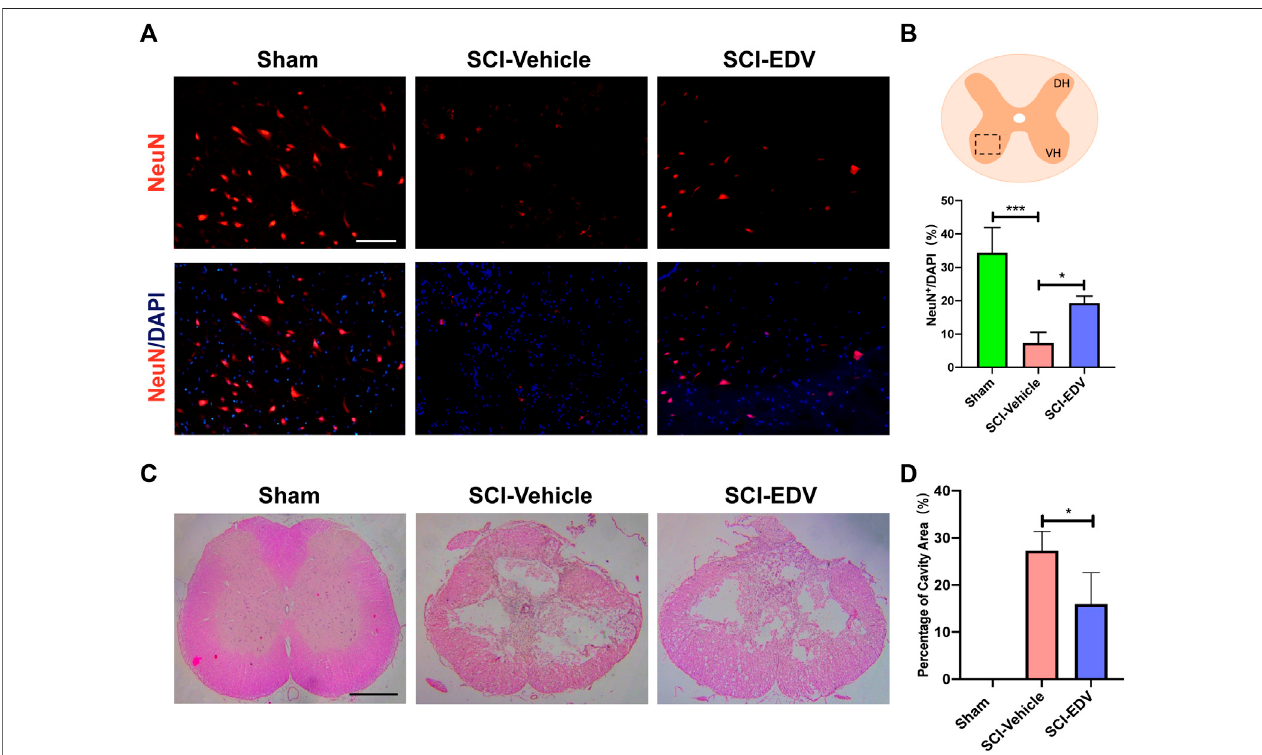
FIGURE 6 | Edaravone has a long-term effect on neuronal survival, reduced astrogliosis, and tissue sparing. (A) Representative images of immuno fl uorescence staining of NeuN in the injury epicenter of 8 weeks post SCI (B) Quanti fi cations of NeuN. (C) Representative images of H&E staining of spinal cord sections at 4 weeks post injury. (D) Quanti fi cation of cavity areas made by ImageJ. Data are expressed as mean ± standard deviation. Statistical signi fi cance was determined by one-way ANOVA with Tukey ’ s post hoc test. * p < 0.05, and *** p < 0.001, n = 3, bar = 100 μ m (A) , bar = 500 μ m (C) .